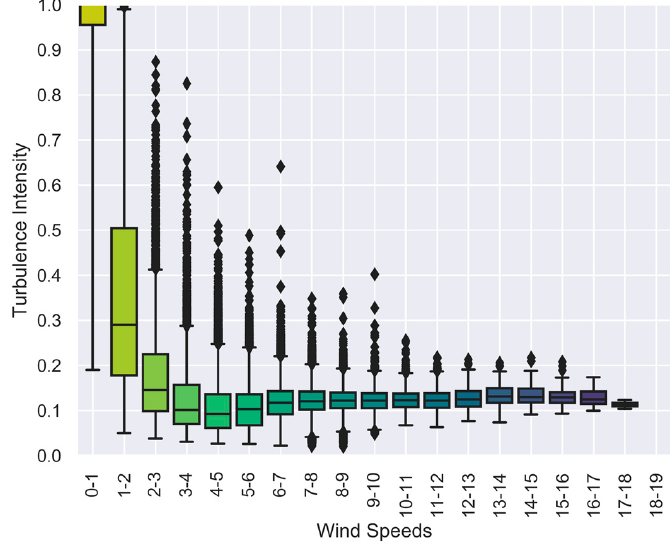
Figure 5. Turbulence intensity (TI) of the wind speeds at 40 m height. This parameter is a common indicator for studying wind variability. Mode and mean wind speeds are associated with a mean wind turbulence of 10%. This variability is used to delimit the study case.